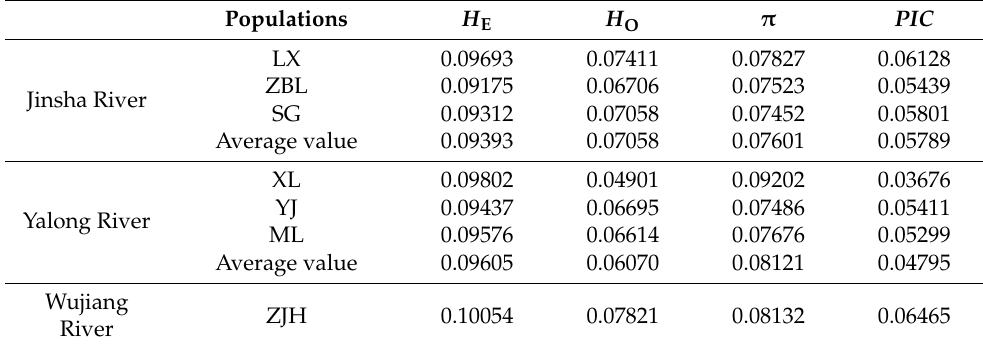
Table 2. Genetic diversity parameters among S. kozlovi populations.